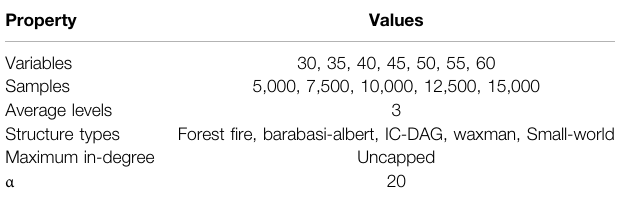
TABLE 3 | The values used for each property when creating synthetic BNs (and their associated datasets) for the SRH datasheet. Combinatorial total of 175 property values, Each con fi guration of properties was repeated 10 times. In total 1750 Bayesian networks and datasets were